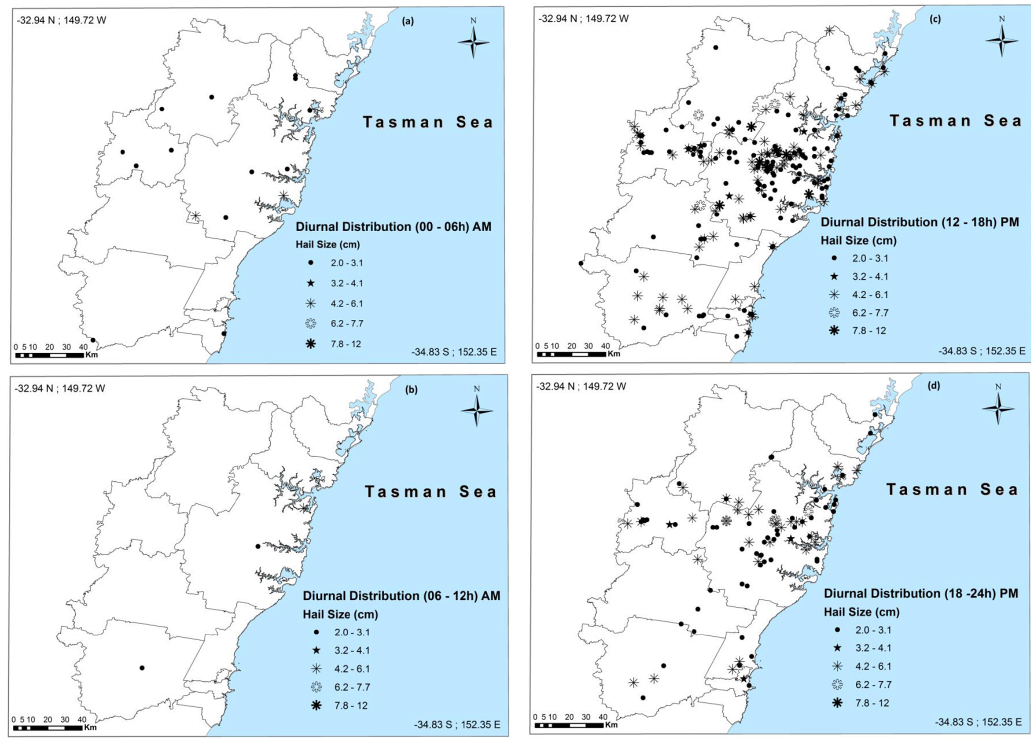
Figure 3. Spatial distribution of the hailstone events in the GMSTWA during (a) 00:00–06:00a.m., (b) 6a.m.–12p.m., (c) 12–6p.m. and (d)